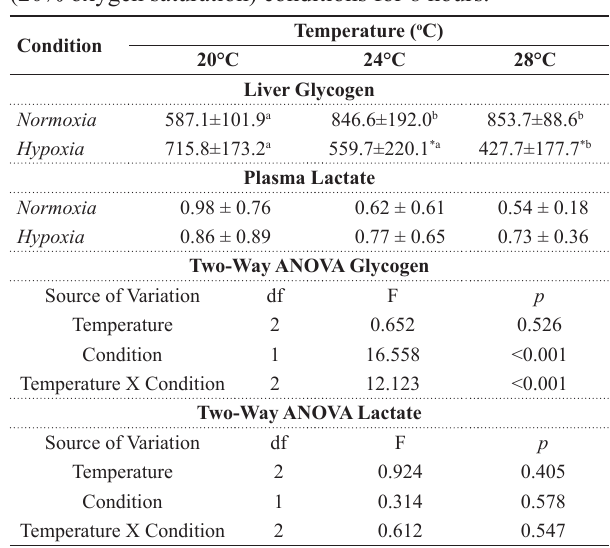
Tab. 1. Two-way ANOVA of liver glycogen and